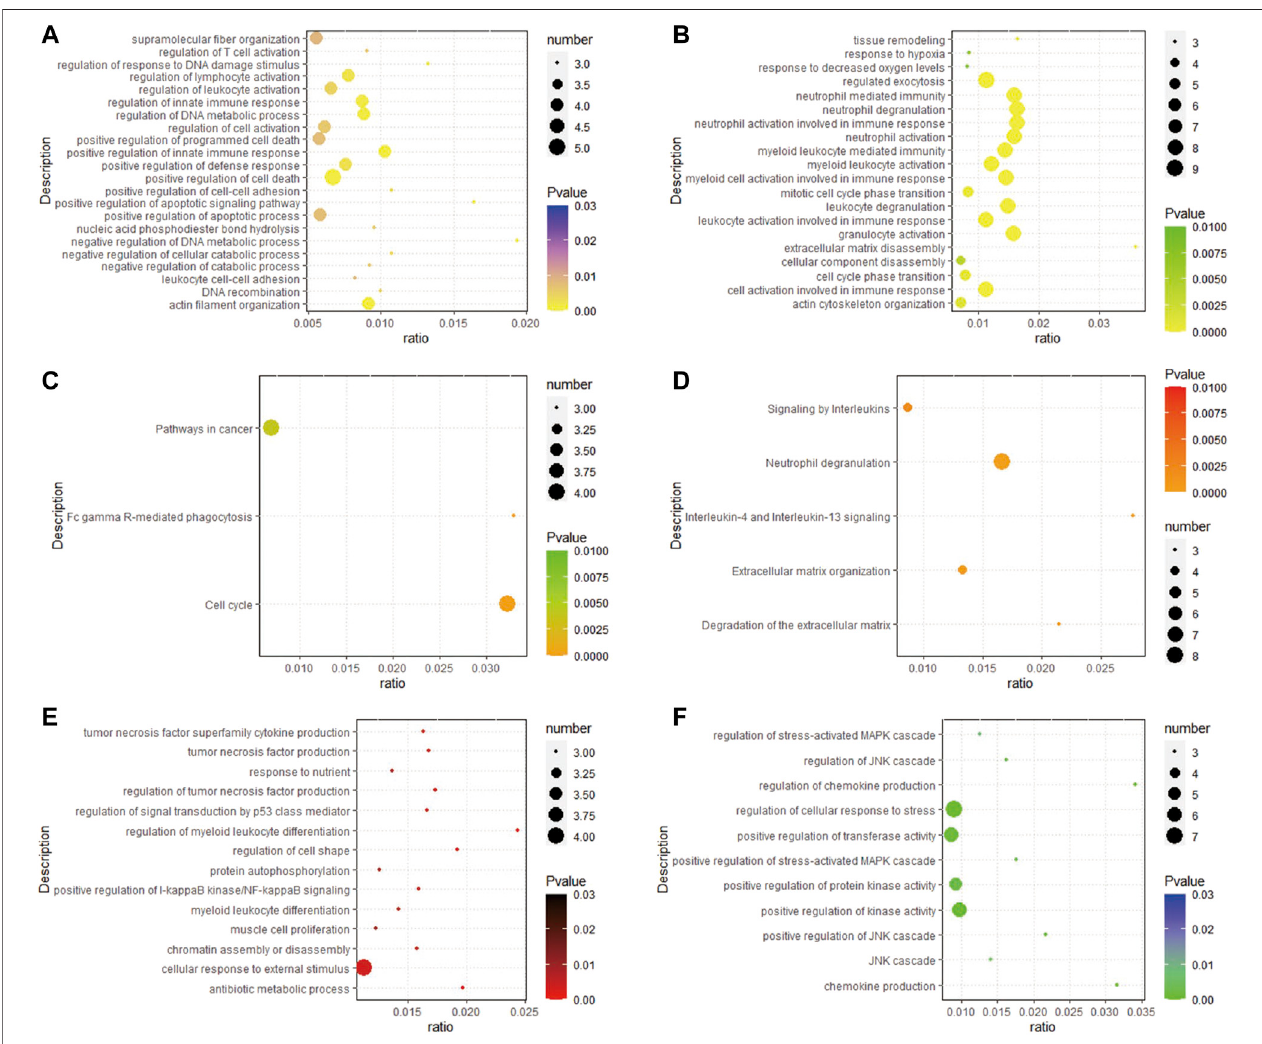
FIGURE 3 | Analysis results of functional enrichment. (A,B) GO analysis of up-regulated DEGs; (C) enrichment analysis of the KEGG of up-regulated DEGs; (D) enrichment analysis of the REACTOME pathway of up-regulated DEGs; (E,F) GO analysis of down-regulated DEGs.